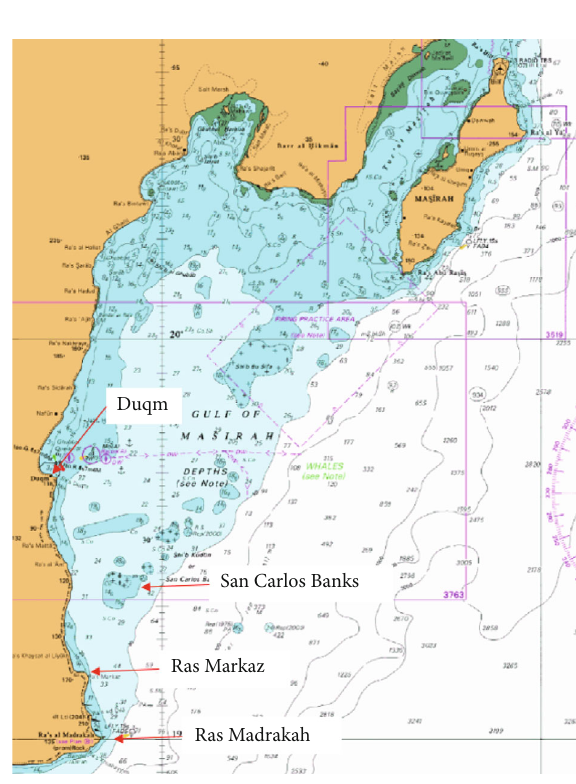
Figure 5: Gulf of Masirah.